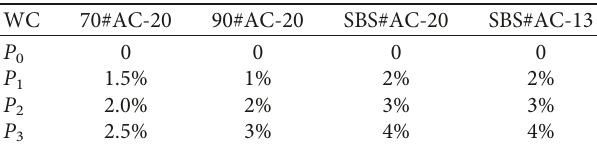
Table 5: Foaming water consumption corresponding to each code of the mix foamed asphalt